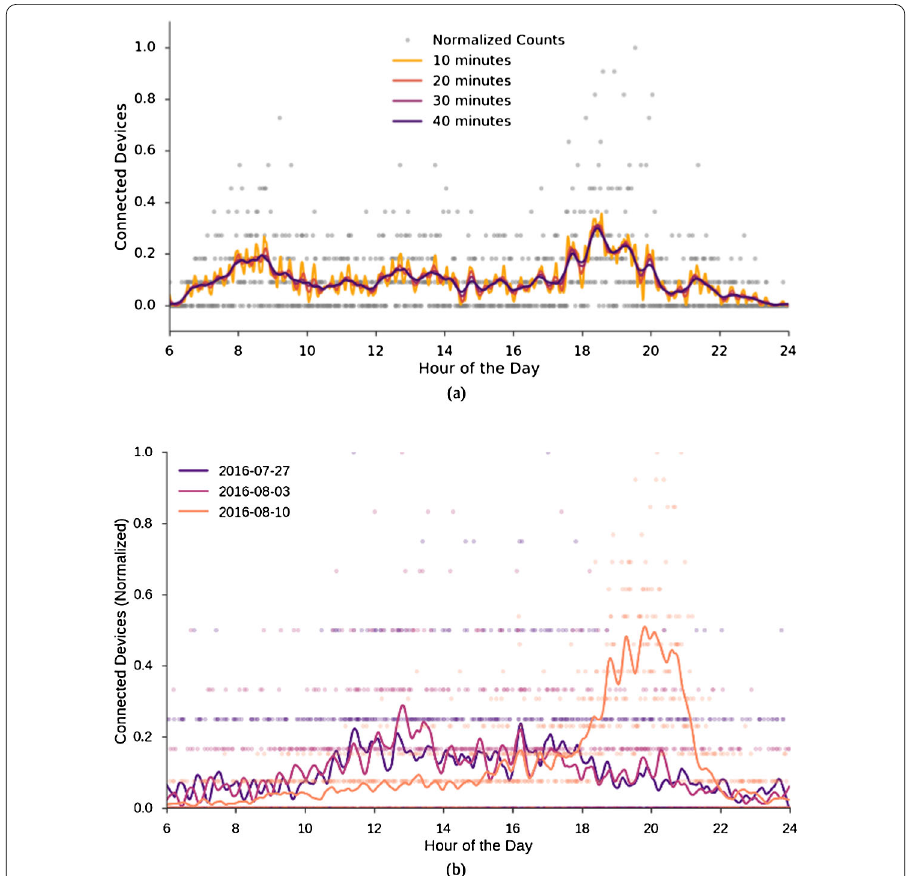
Figure 2 Connected device counts at a specific cell tower (a), and at a zone, aggregating several towers (b). Each dot represents the number of connections at a specific time of the day. The curves represent LOWESS interpolation of the number of connected